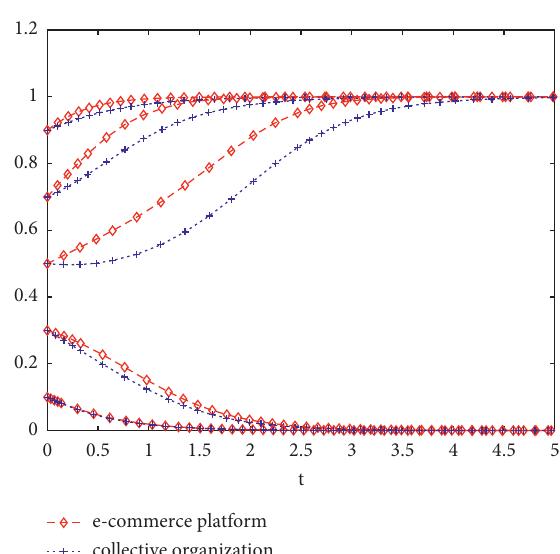
Figure 7: The stability analysis of Model II ( μ � 0 ·